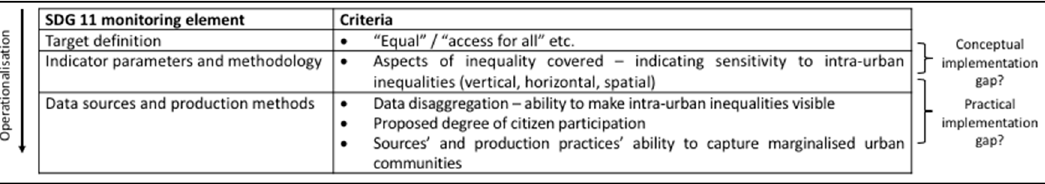
Figure 2. The methodological